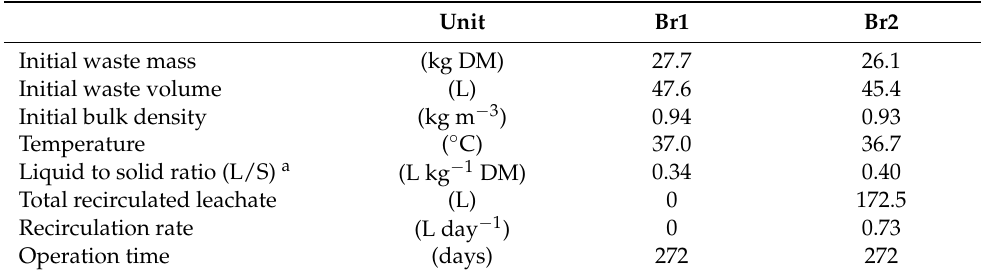
Table 1. Operation conditions in landfill simulation reactors.